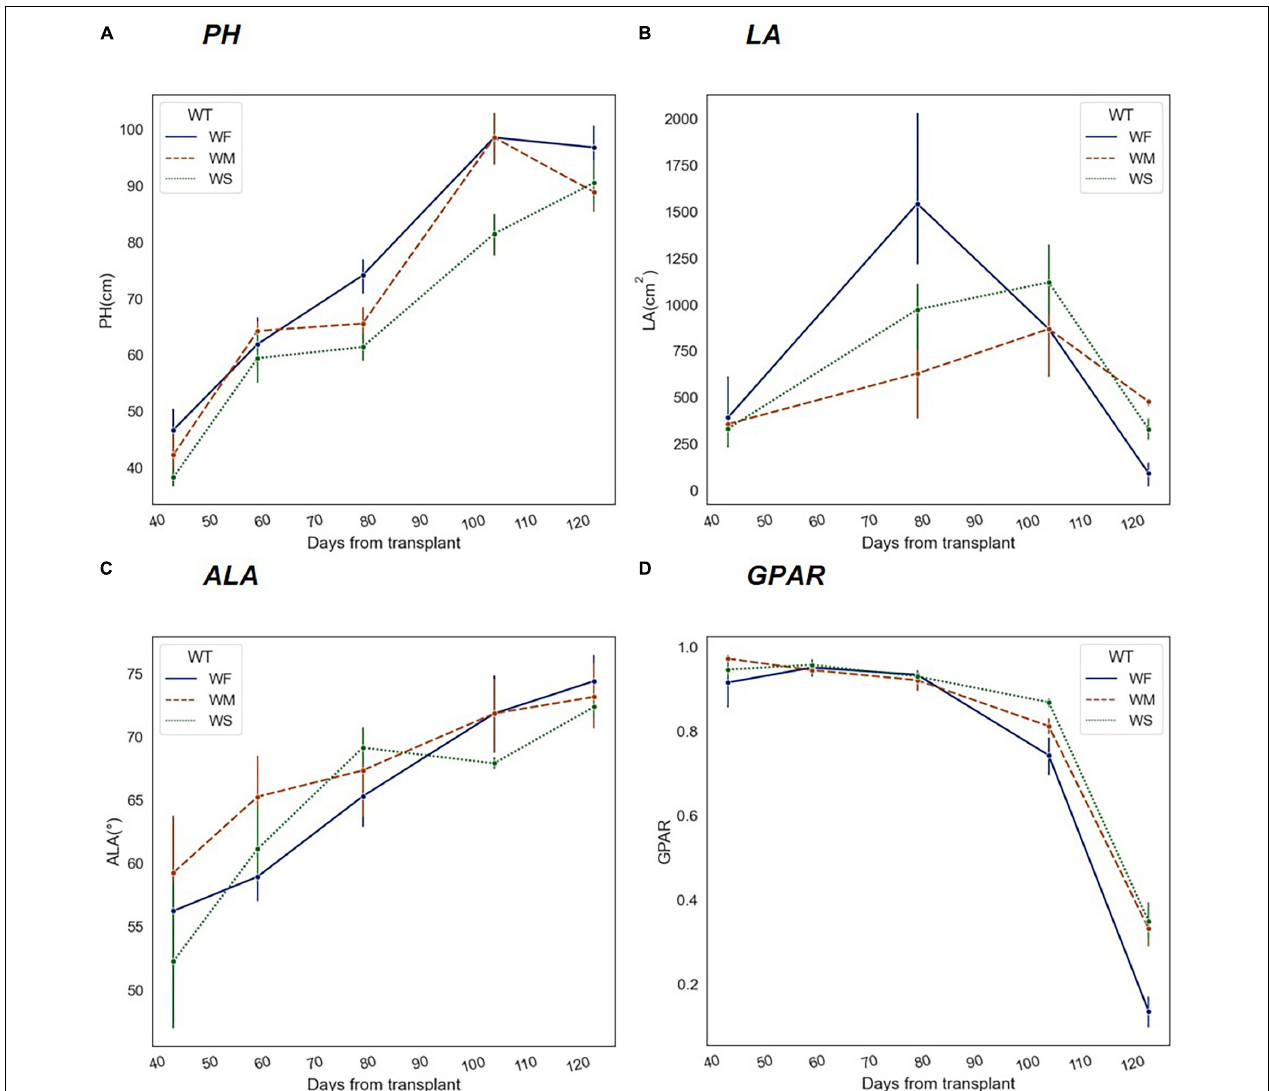
FIGURE 5 | Trends of phenotypic traits in different water treatment groups (WF, WM, and WS) during the whole growth period. The x -axis represents the number of days experienced after rice transplanting. (A) Plant height ( PH ), (B) Leaf area ( LA ), (C) Average leaf angle ( ALA ), and (D) Greenness ratio ( GPAR ).